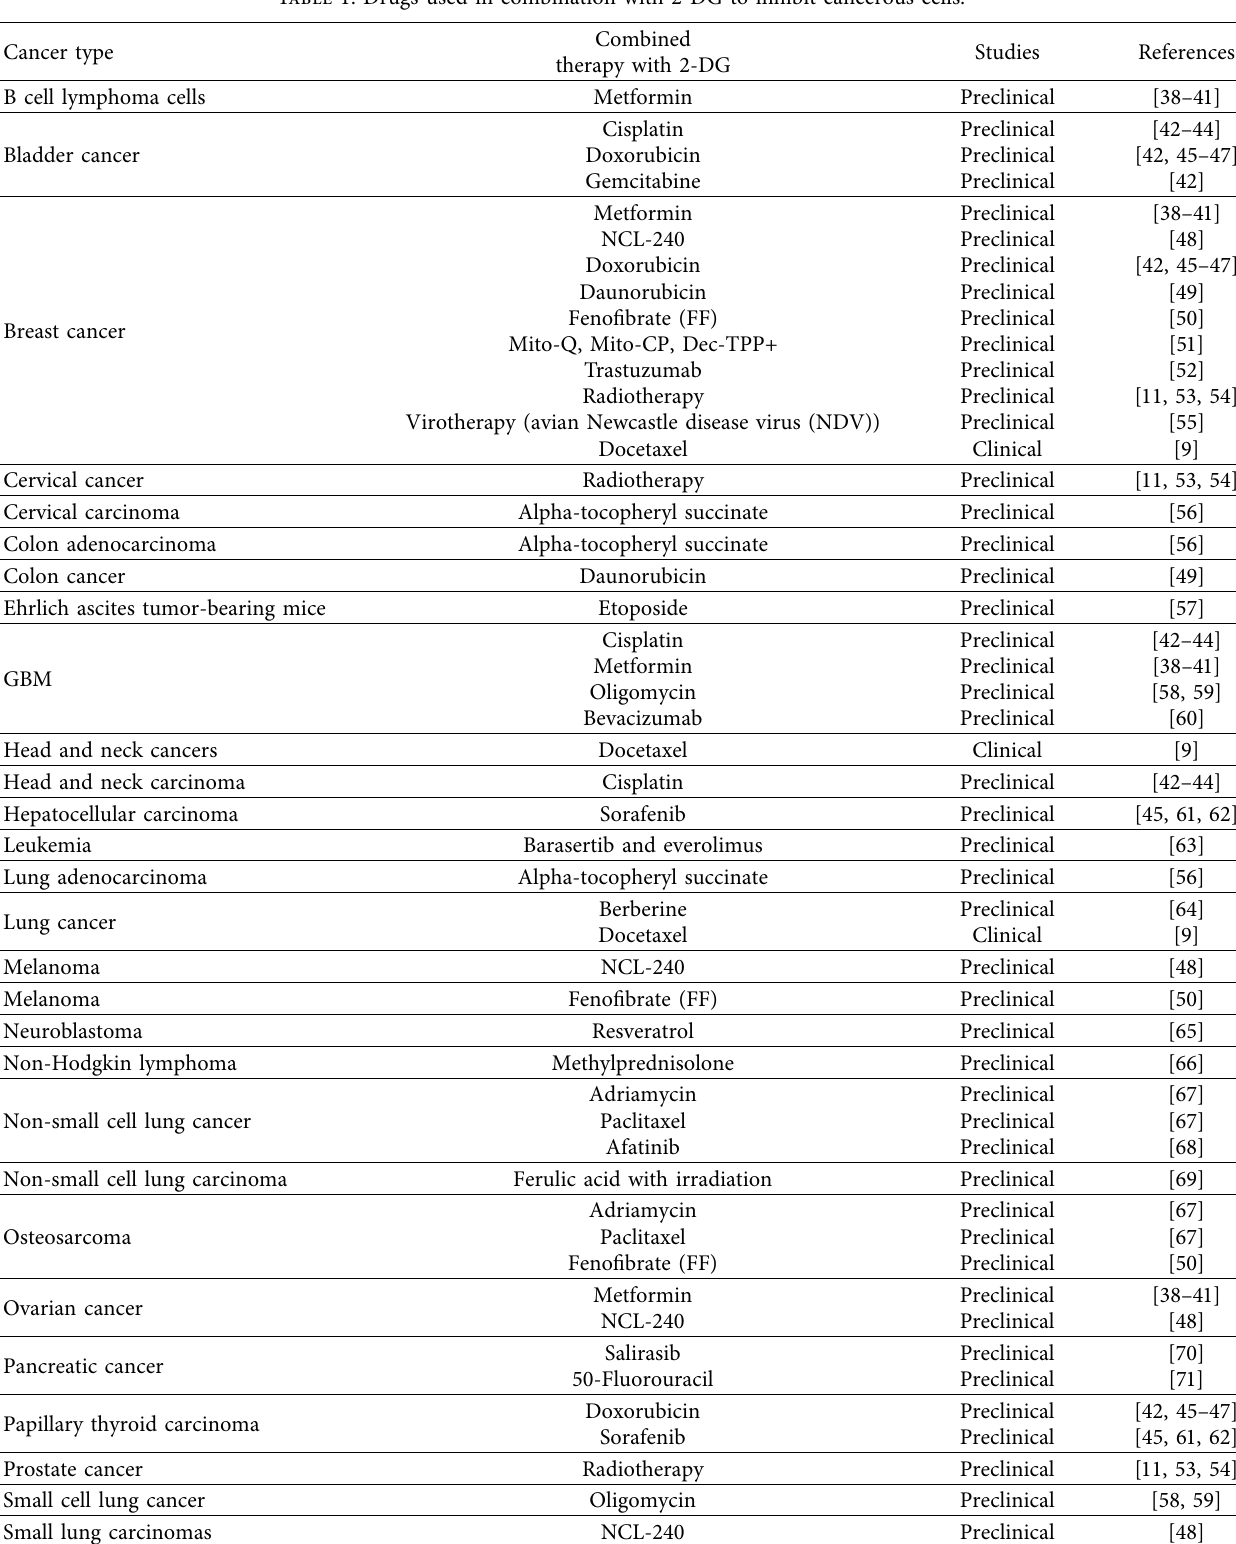
Table 1: Drugs used in combination with 2-DG to inhibit cancerous